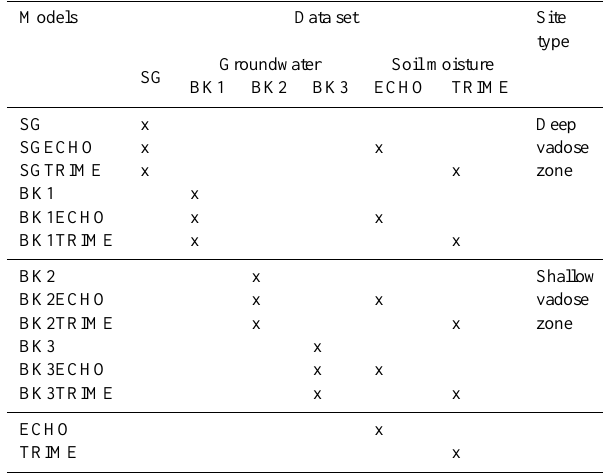
Table 3. The different calibrated models based on the different data sources and the site